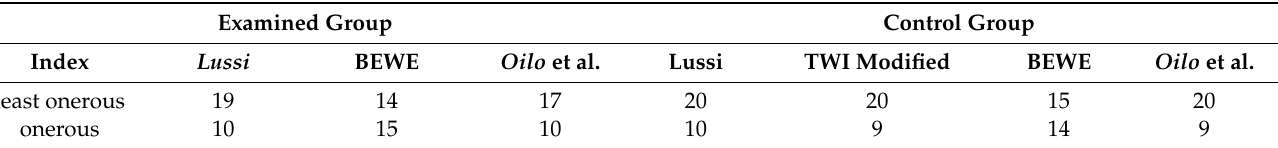
Table 5. Comparison of the most frequently selected indexes during all appointments in examined and control